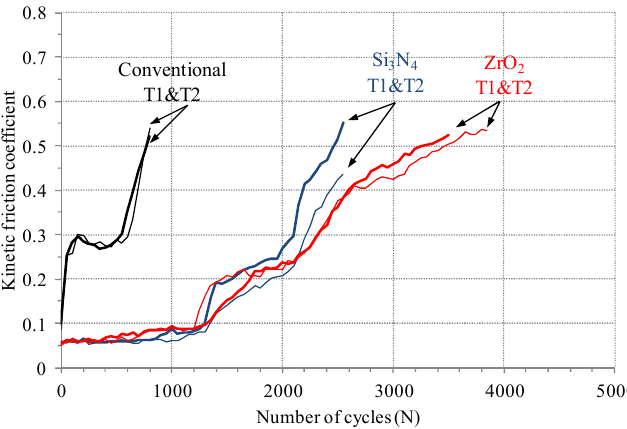
Figure 3. The kinetic friction coefficient evolution between an electro-deposited coating and a ball. “Conventional” denotes AISI 52100 ball. T1 and T2 mean tests 1 and 2, respectively.